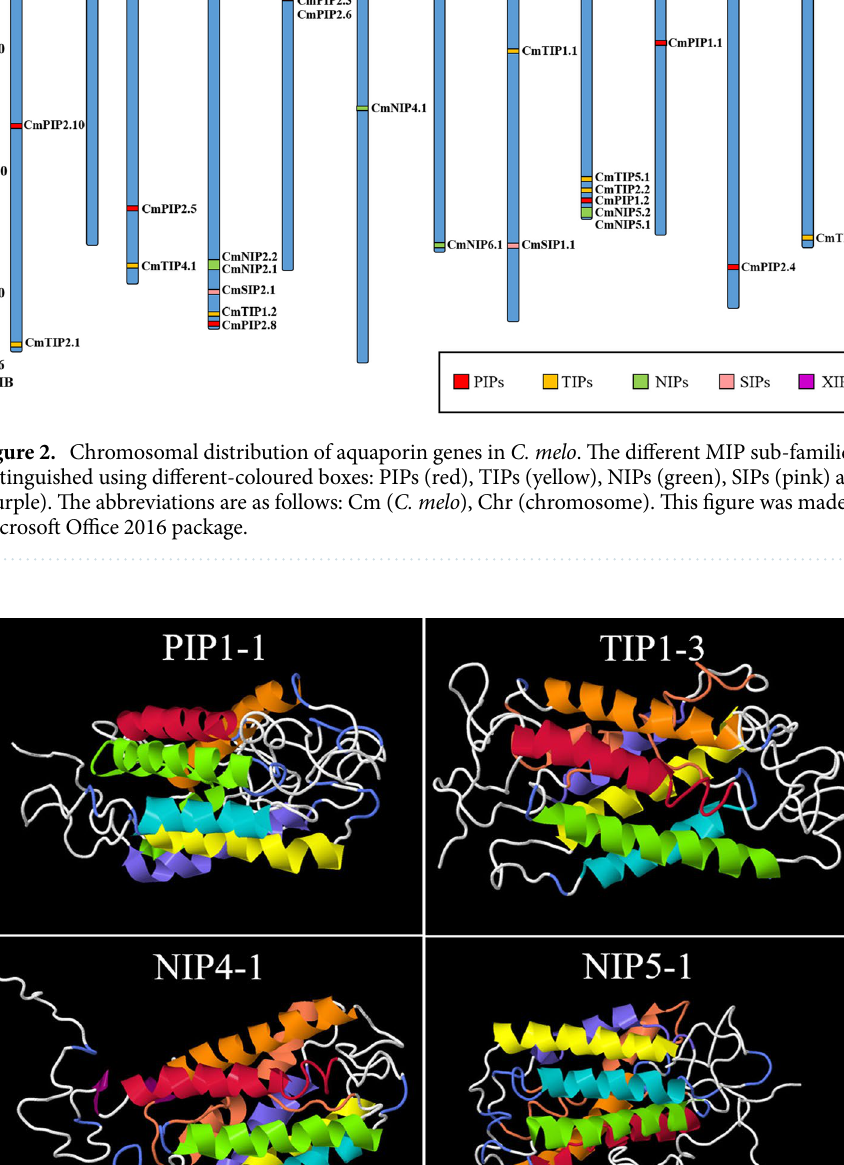
were predicted in the tonoplast, with certain exceptions: The Wolf-PSORT program predicts CmTIP1;1 in the plasma membrane, CmTIP3;1 in the mitochondrial membrane and CmTIP5.1 in the chloroplast membrane. As for the NIPs, almost all were predicted to have a plasma membrane localisation—except CmNIP2;1, CmNIP4;1, CmNIP5;2 and CmNIP6;1, which Wolf-PSORT placed in the tonoplast.